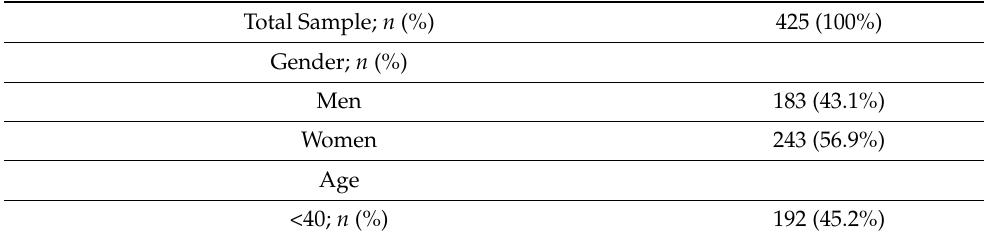
Table 3. The sociodemographic and workload characteristics of the